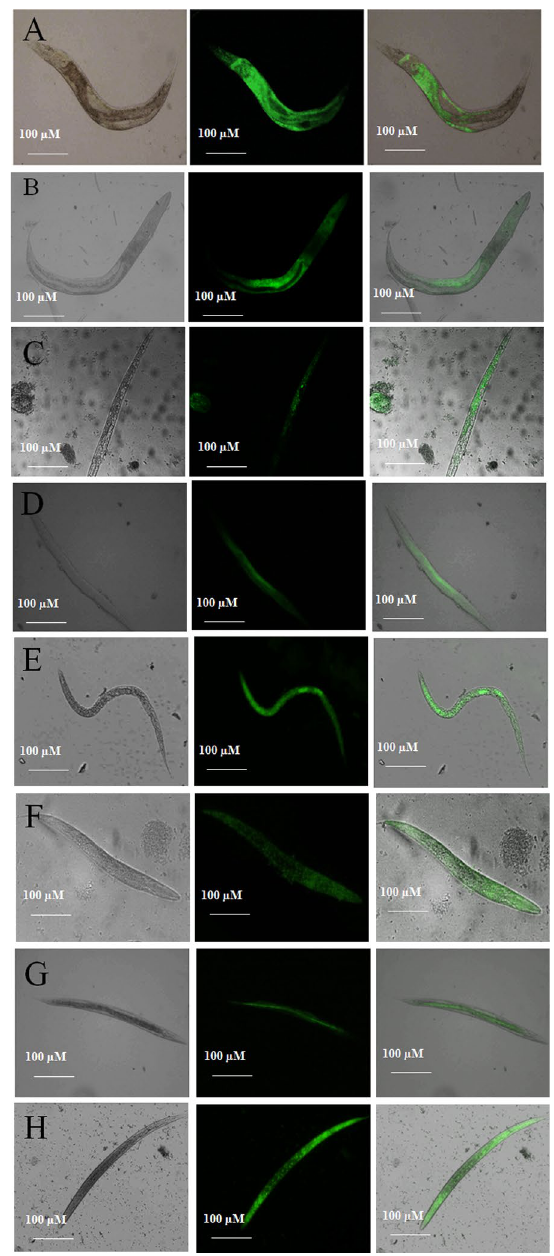
Figure 16. HCS images of colonization by P.aeruginosa and MRSA under treatment conditions. ( A ) C. elegans infected with P.aeruginosa, ( B ) C. elegans infected with P.aeruginosa and treated with LP alone, ( C ) C. elegans infected with P.aeruginosa and treated with Cu-NPs alone, ( D ) C. elegans infected with P.aeruginosa and treated with LP + Cu-NPs, ( E ) C. elegans infected with MRSA, ( B ) C. elegans infected with MRSA and treated with LP alone, ( C ) C. elegans infected with MRSA and treated with Cu-NPs alone, ( D ) C. elegans infected with MRSA and treated with LP +